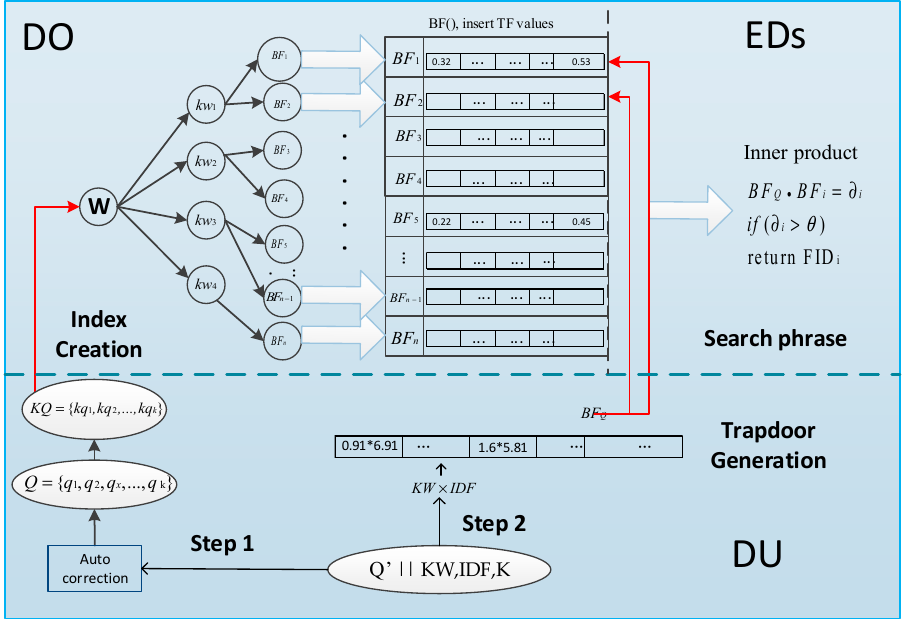
Figure 7. The main framework of our scheme.